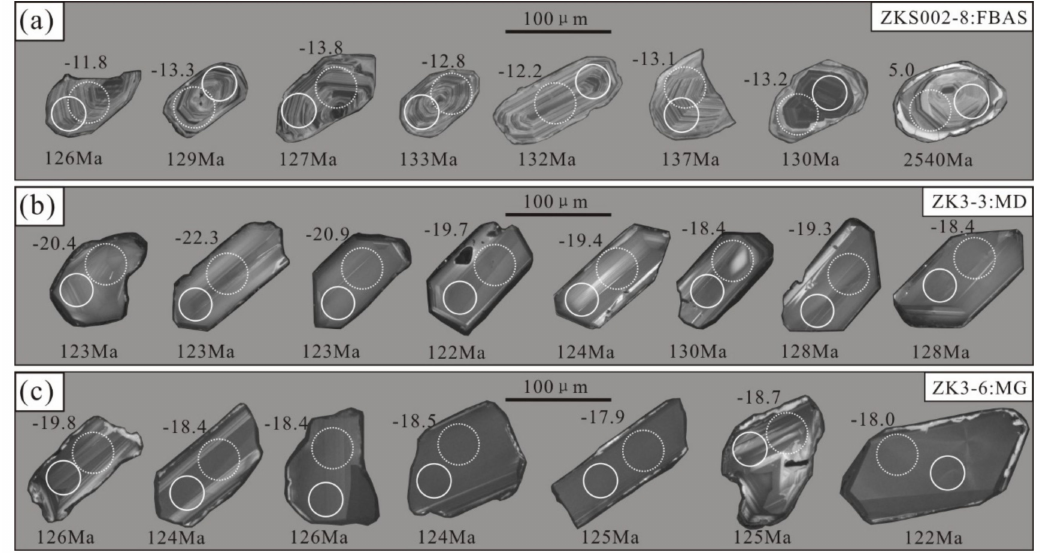
Figure 5. ( a – c ) Cathodoluminescence (CL) images of selected zircons from the FBAS, MD, and GD, respectively. The solid lines and the dash lines represent the locations of analysis spots used for U-Pb dating and Hf isotopic analyses,